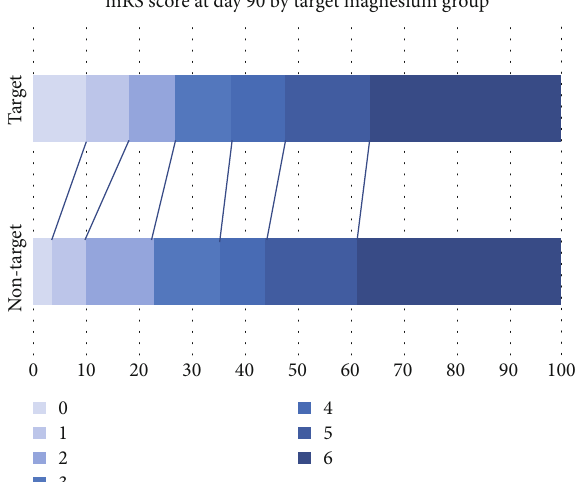
Figure 2: Functional outcomes at 90 days in the target and nontarget groups of patients with CAEs, according to score on the Modi fi ed Rankin